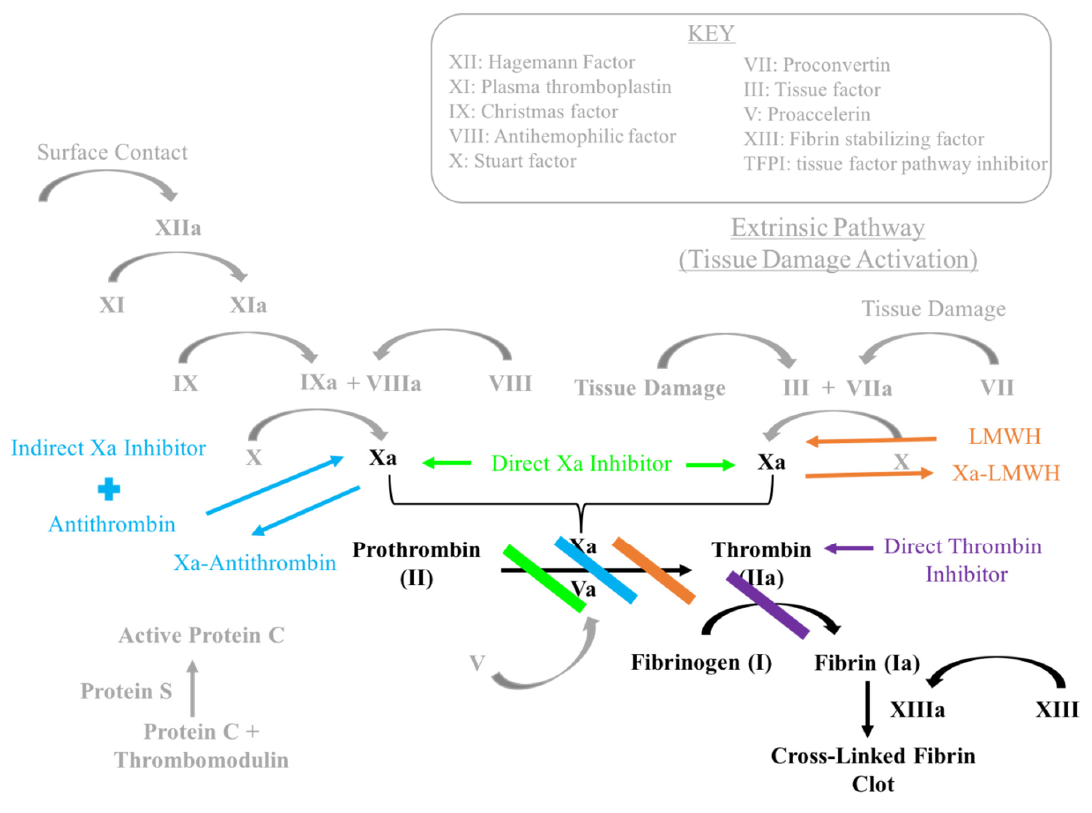
Figure 2. Overview of the coagulation